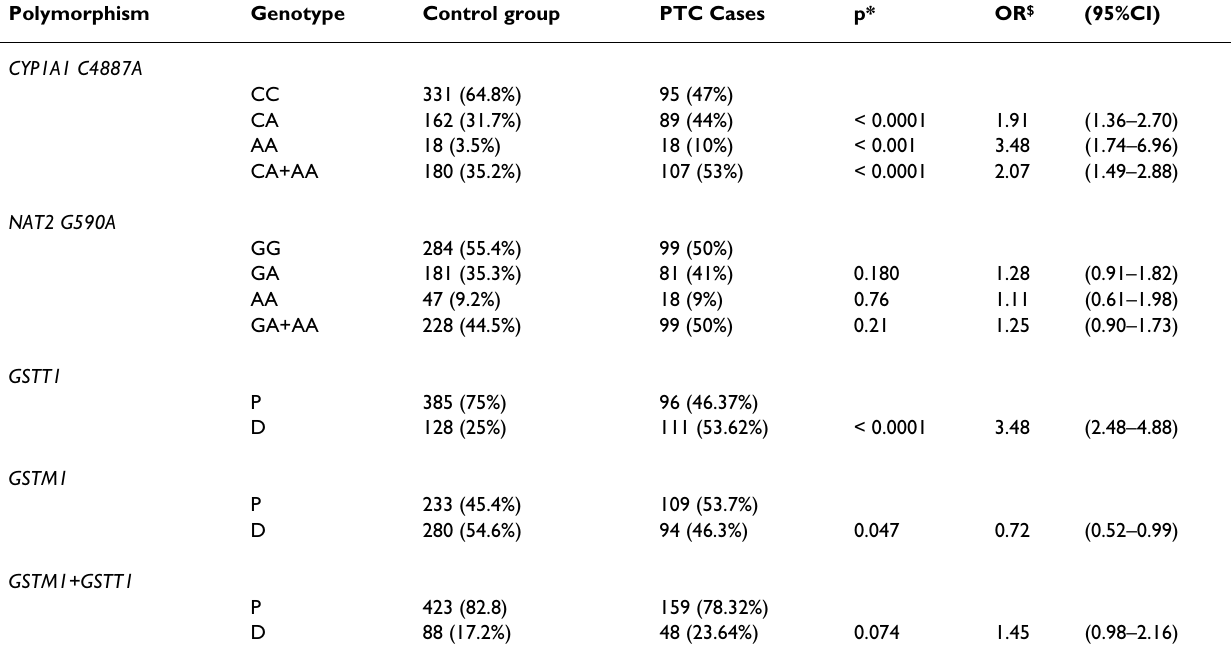
Table 2: Distribution of Xenobiotic genes polymorphisms in healthy population and PTC cases (n = 223).